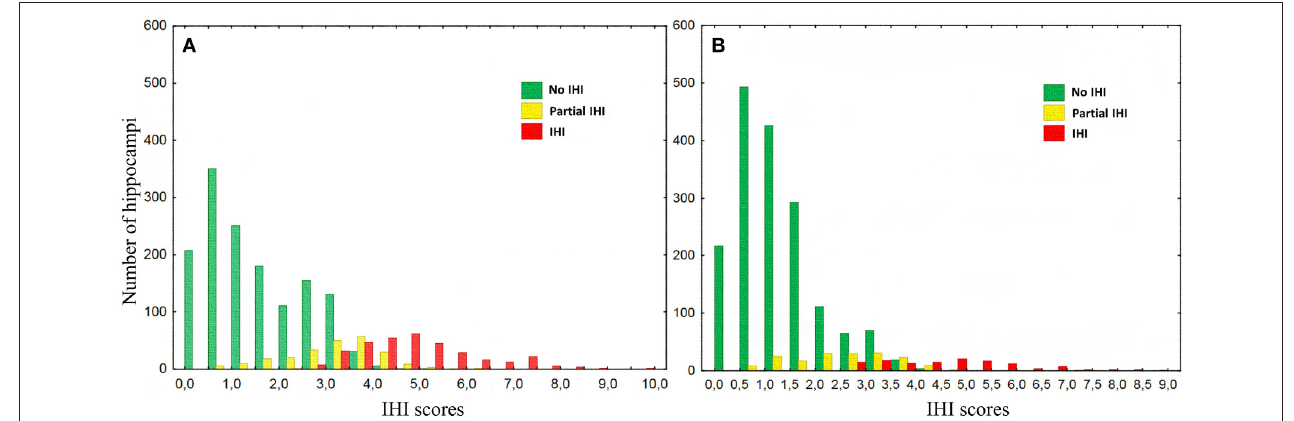
FIGURE 4 | Histograms of the sum of grades of individual criteria categorized by the global criterion C0, for left (A) and right (B) hippocampi.